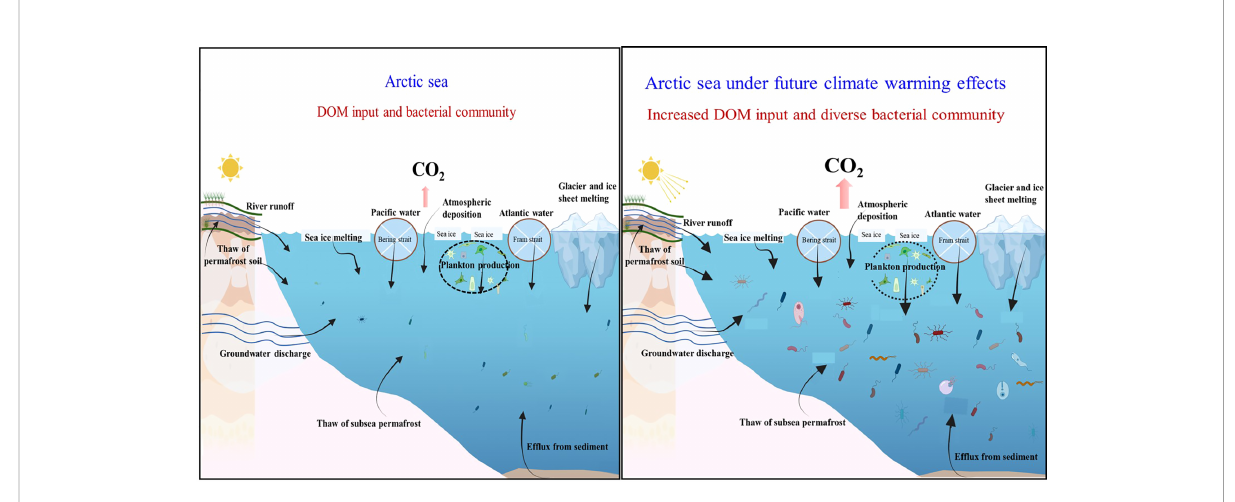
FIGURE 4 Changes in DOM input and its consequence on the bacterial community in the Arctic Ocean under the effects of climate warming. The arrows represent DOM